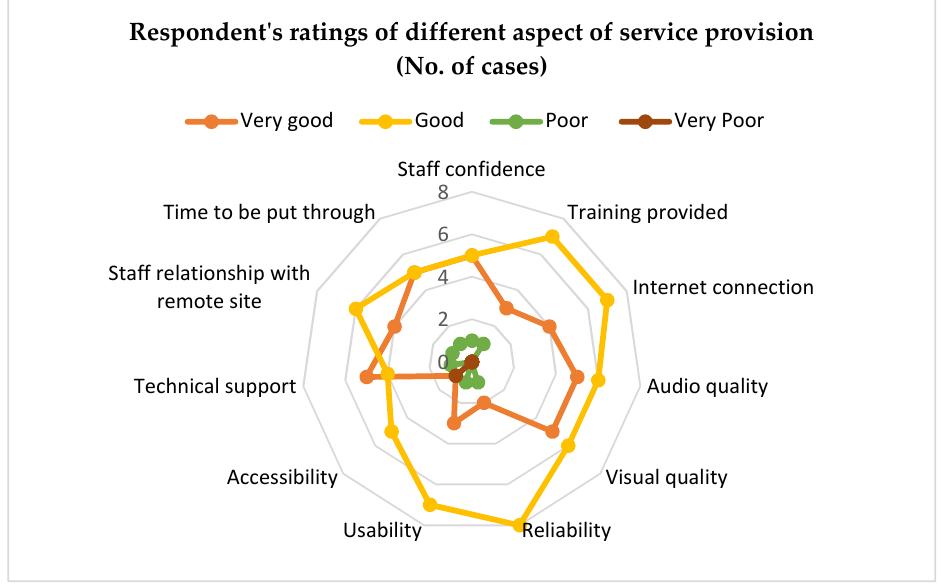
Figure 3. Respondent’s ratings of different aspects of service provision.